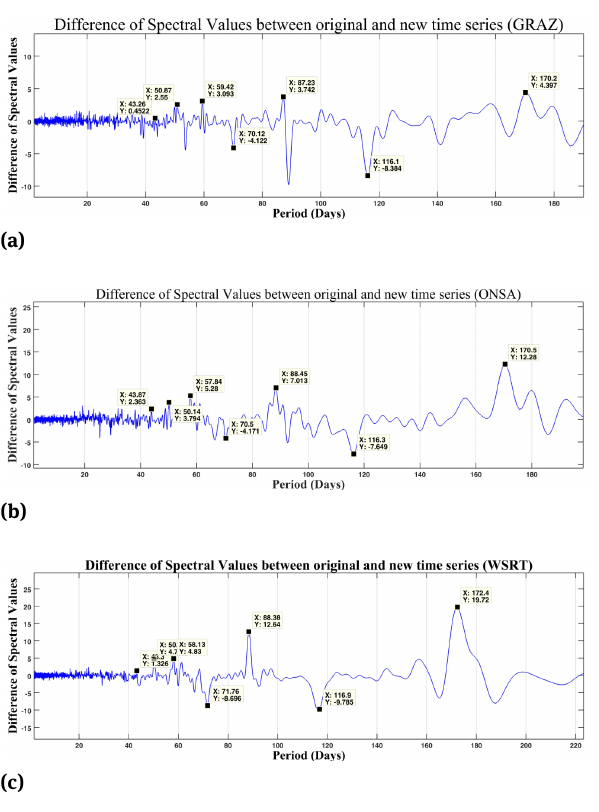
Figure 13: difference between spectral values for original and new time series - X is period and Y is difference of spectral values. Sta- tion: (a) GRAZ, (b) ONSA, (c) WSRT.